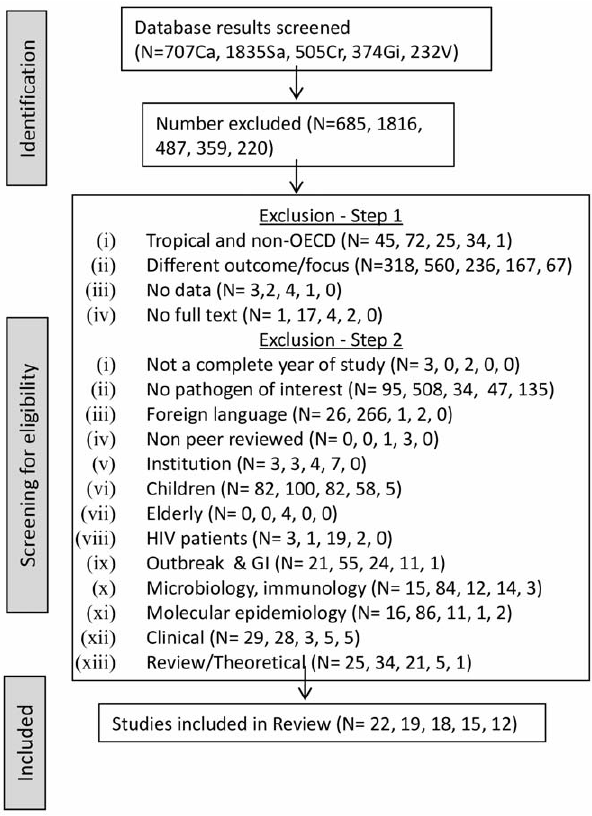
Figure 1. Flow chart illustrating criteria for study selection. The grey boxes represent the three major steps relating to article selection process. N is the total number of papers found across all three database searches; the suffixes represent the disease (Ca-Campylobacteriosis, Sa- Salmonellosis, V-VTEC, Cr-Cryptosporidiosis, Gi-Giardiasis). This order is maintained throughout the